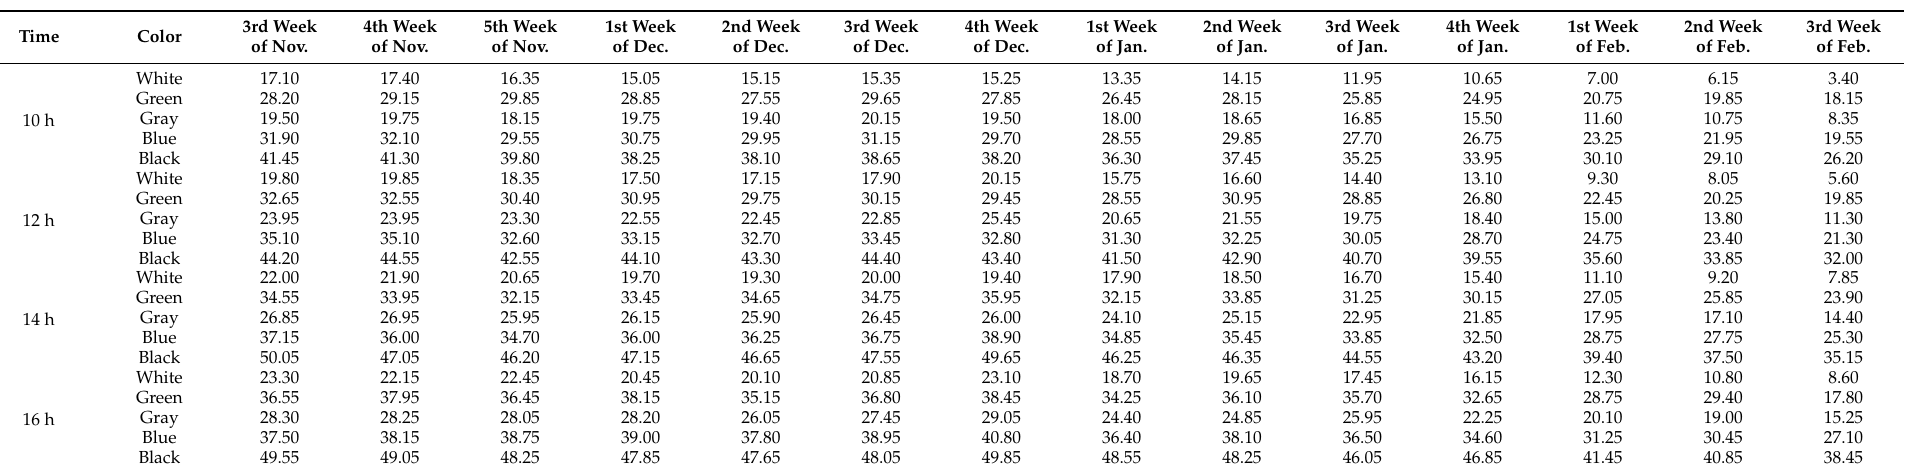
Table 4. Weekly rooftop surface average temperatures at different times ( ◦ C).